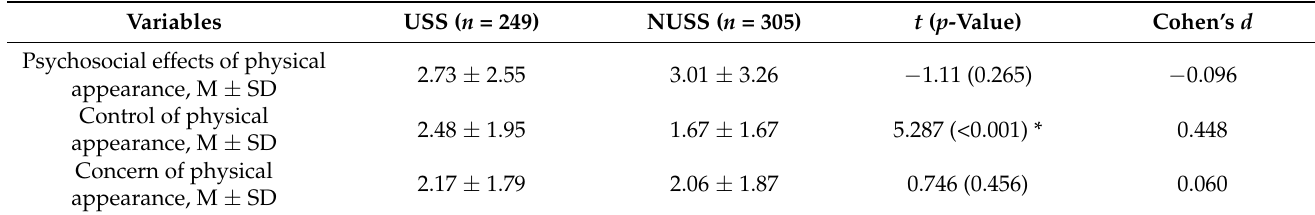
Table 5. Differences between USS and NUSS in Adonis Complex.